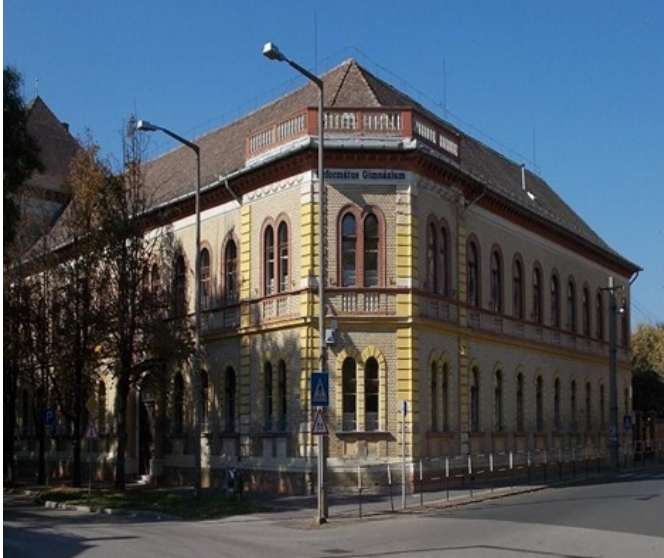
Figure 4. Historical building—secondary school in Karcag.